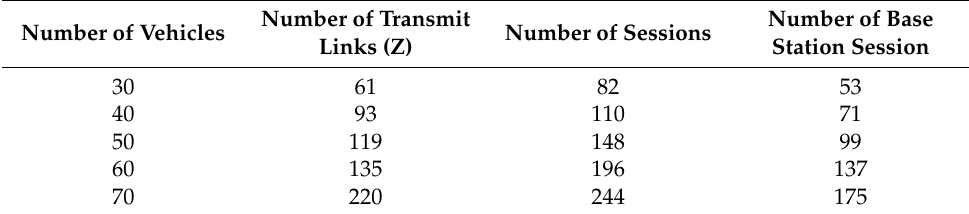
Table 7. The number of Sessions and Transmit Links.